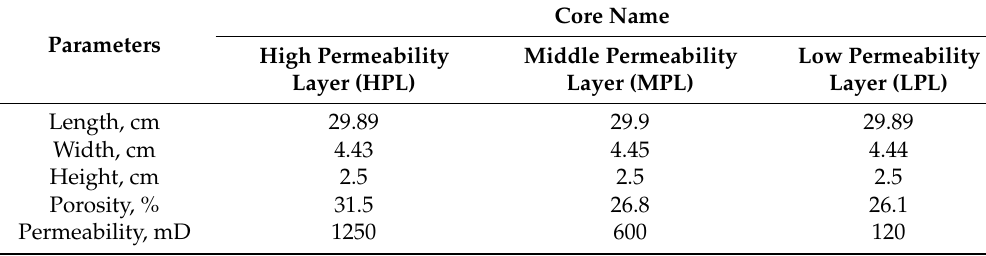
Table 4. Core sample